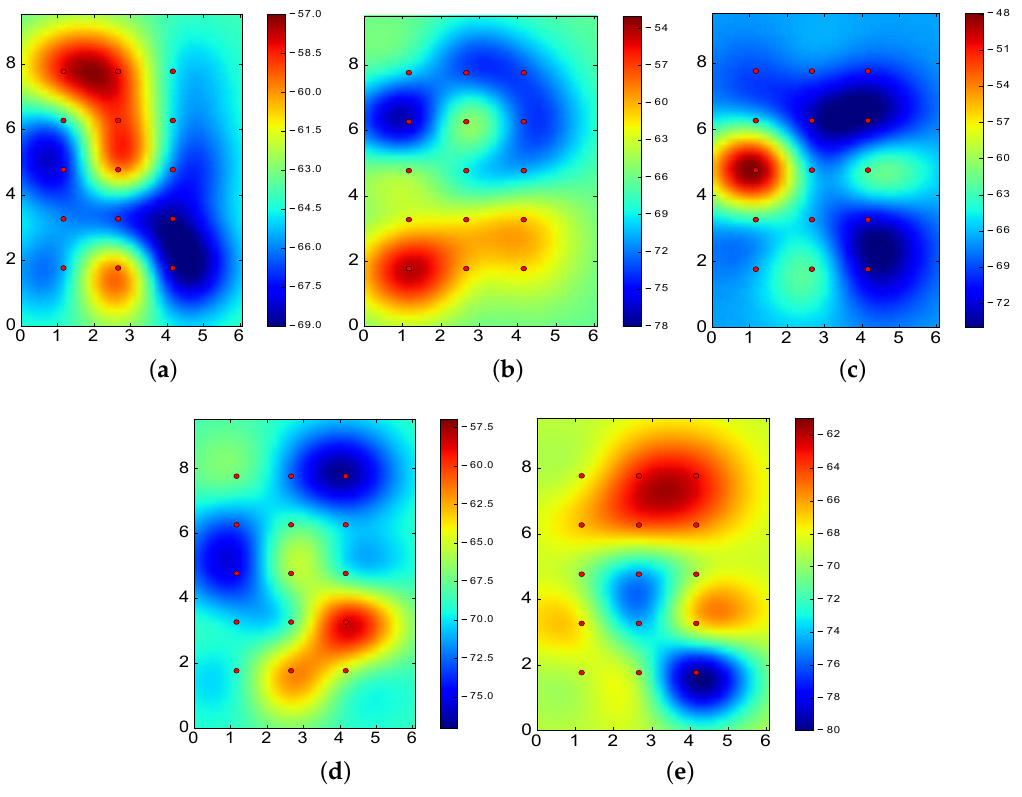
Figure 13. RSSI values using the most relevant transmission power ( Tx ) level setting for each BLE4.0 beacon: [4,1,2,1,1]. ( a ) ’Be07’ with Tx = 0x04; ( b ) ’Be08’ with Tx = 0x01; ( c ) ’Be09’ with Tx = 0x02; ( d ) ’Be10’ with Tx = 0x01; ( e ) ’Be11’ with Tx = 0x01.